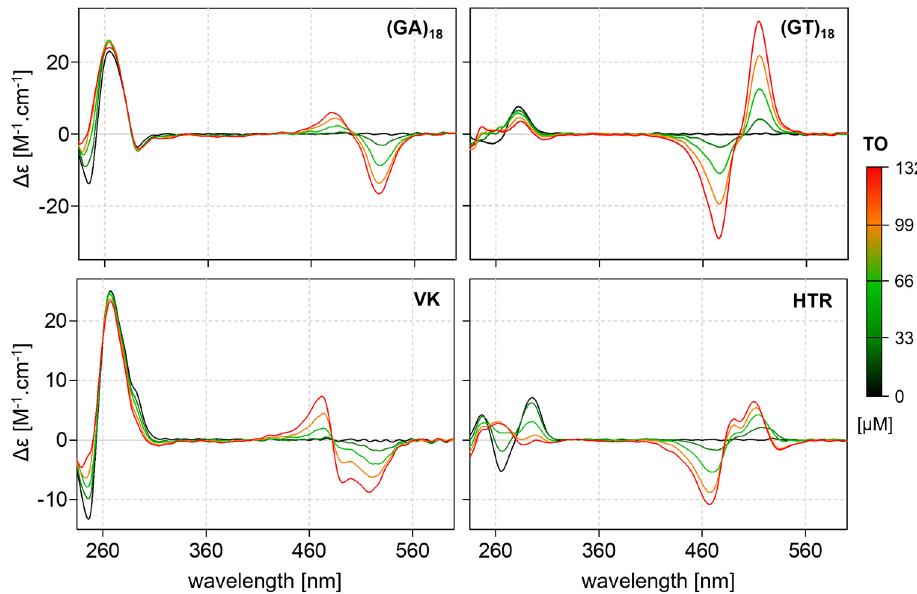
Figure 8. CD spectra of (GA) 18 and (GT) 18 in the presence of different concentrations of TO ( top ) and analogous CD spectra of VK and HTR sequences under the same conditions ( bottom ). DNA sample concentration is 25 µM and the TO increment is 33 µM.